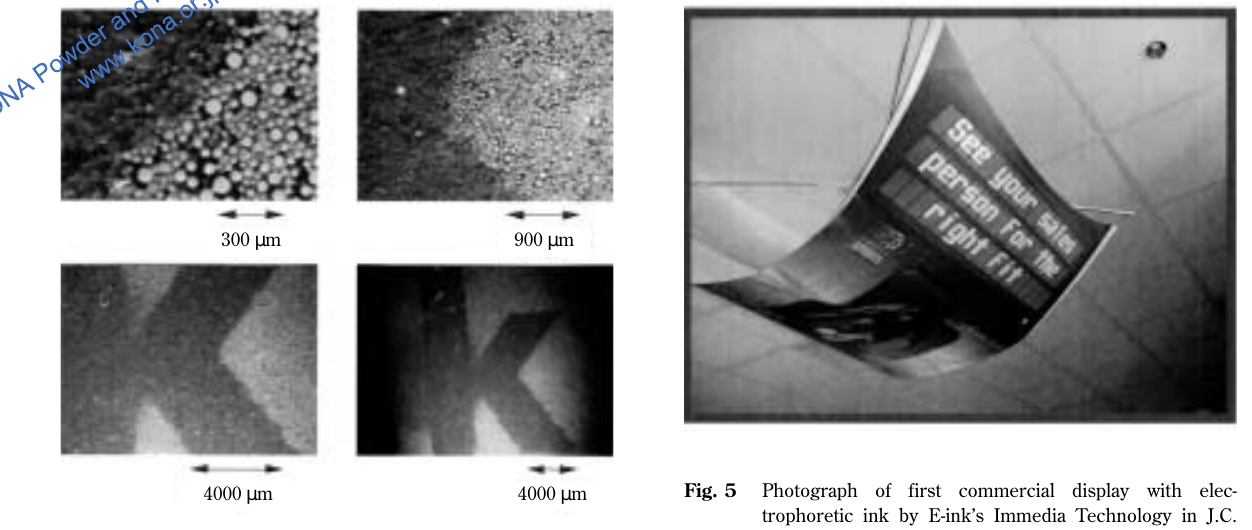
Fig. 4 Photograph of display image of microencapsulated elec- trophoretic display system